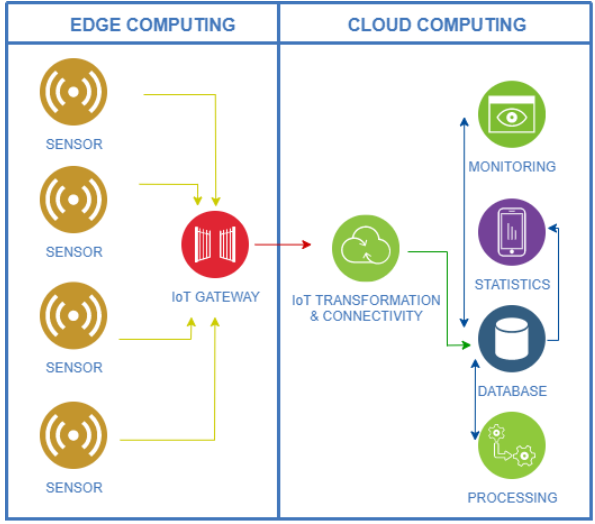
Figure 7. Infrastructure of the Internet of Things (IoT)